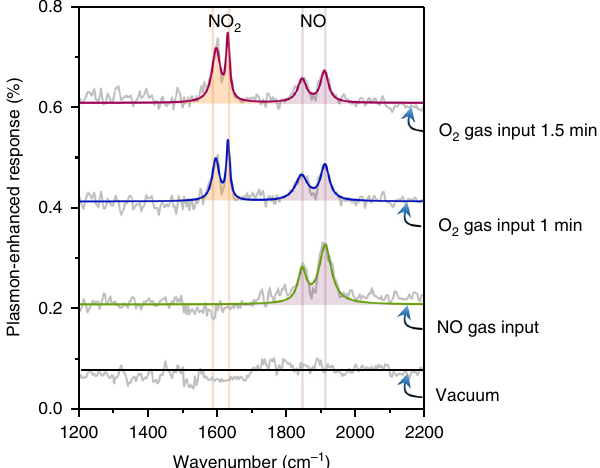
Fig. 4 Identi fi cation of gas molecules during chemical reactions. From bottom to top: plasmon-enhanced molecular signals in a chamber fi lled with no gas (i.e. vacuum), 1 min and 1.5 min after O 2 input.